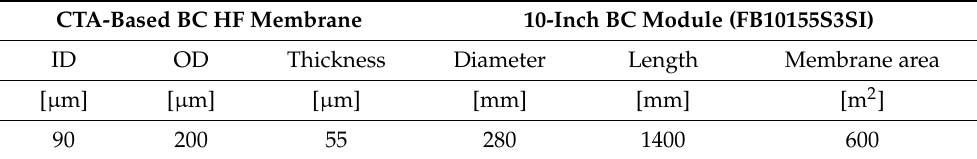
Table 2. Developed CTA-based HF membrane and 10-inch module specialized for BC